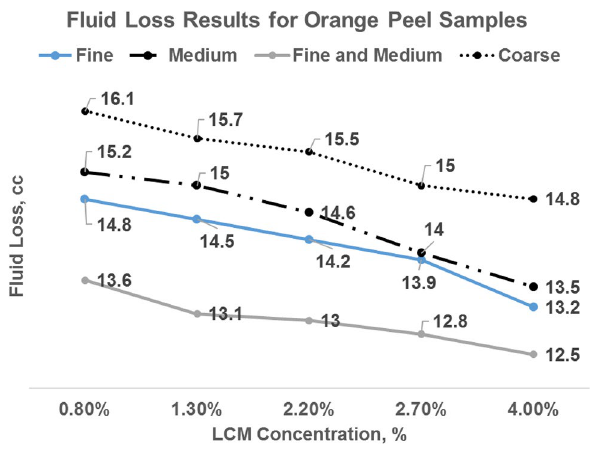
Fig. 7 Fluid loss results for orange peel